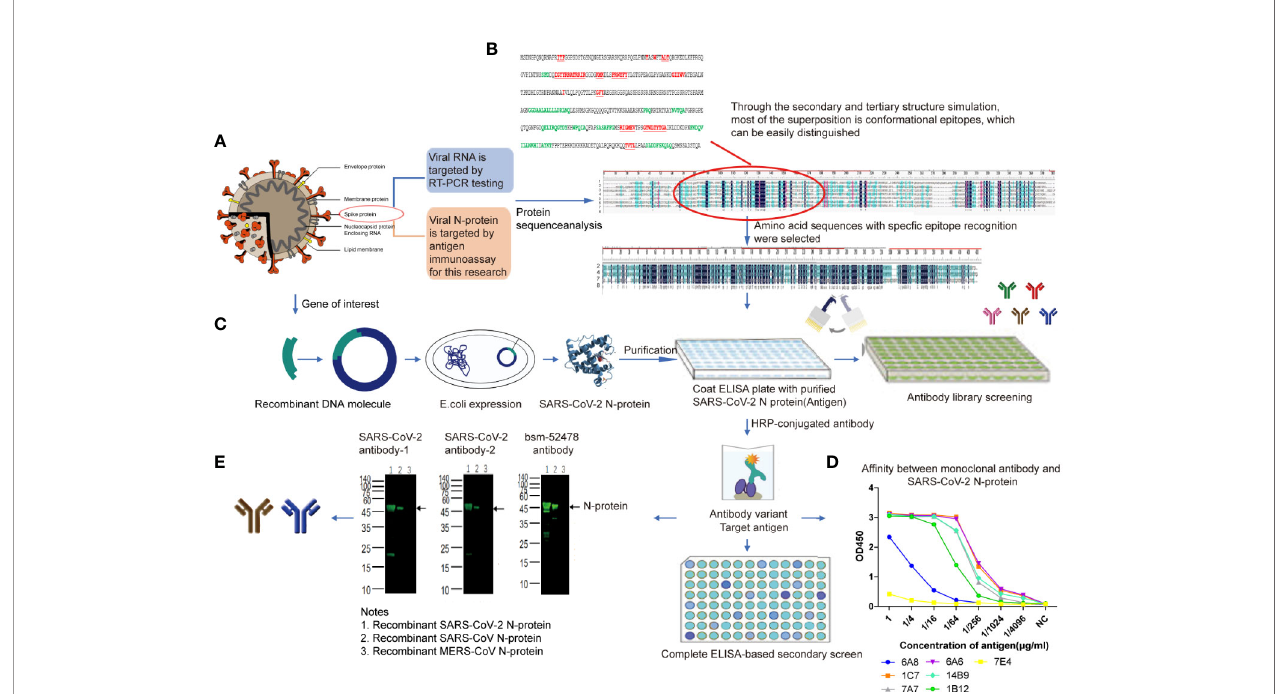
FIGURE 1 | SARS-CoV-2 N-protein speci fi c antibody selection and cross reaction (A) . SARS-CoV-2 N-protein was chose for antigen immunoassay (B) . The sequence comparison between SARS-CoV-2 N-protein and that of the other 6 kinds of coronaviruses. From the top to the bottom of the list: 1, HCoV-229E (AOG74787.1_N); 2, SARS-CoV-2 (YP009724397.2_N); 3, HCoV-HKU1(AGW27885.1_N); 4,MERS-CoV (AHC74105.1_N); 5, HCoV-NL63 (AFV53152.1_N); 6, HCoV-OC43 (QDH43730.1_N); 7, SARS-CoV ShanghaiQXC1(AAR86795.1_N); 8,consensus sequence, the black area (C) . The expression of SARS-CoV-2 N- protein (D) . Af fi nity determination between monoclonal antibody and SARS-CoV-2 N-protein. 6A8, 6A6, 7e4, 1c7, 14b9, 7a7, and 1B12 represent seven monoclonal antibodies selected from antibody library of Beijing Biosynthesis Biotechnology Co. Ltd (E) . Cross-reaction result. Anti-SARS-CoV-2 N-protein monoclonal antibody-1 and antibody-2 were selected as immune